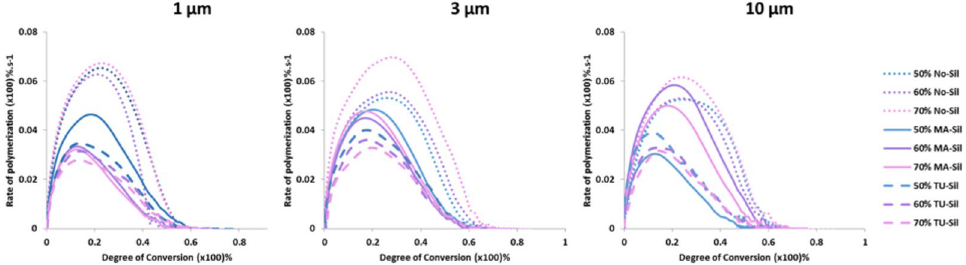
Figure 4. Rate of polymerization (%.s −1 ) as a function of degree of conversion (%) for experimental resin composites containing different filler particle contents. Vinyl conversion was followed in real-time by near-IR for 180 s.